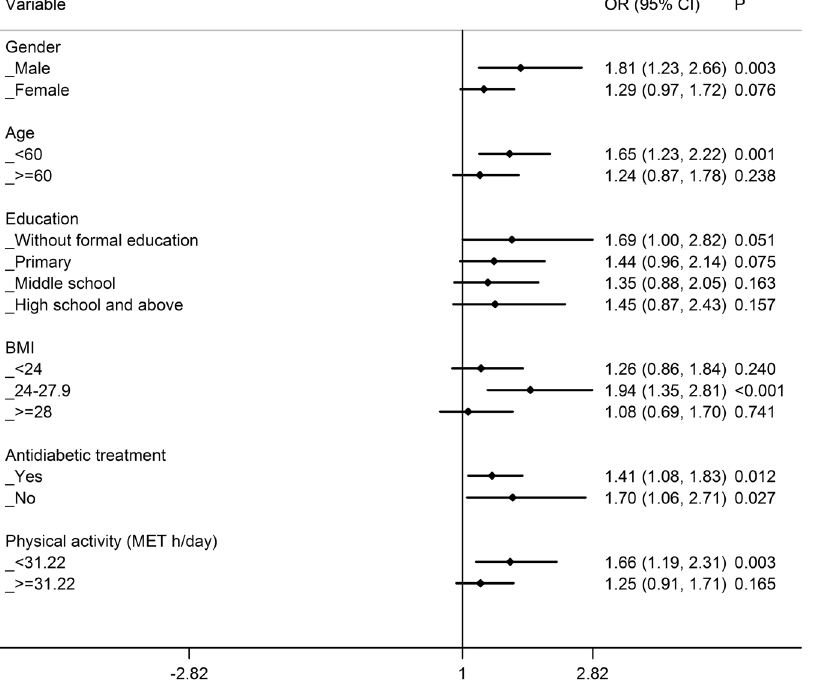
Figure 2. Stratified analysis of the comparison of poor glycaemic control between T2D patients with maternal history of diabetes and patients without a FH of diabetes by age, gender, education, BMI, antidiabetic treatment and physical activity. Logistic regression was used to estimate the OR (95%CI) and each stratified analysis was adjusted for age, gender, education, BMI, antidiabetic treatment, physical activity, smoking, drinking, spouse with diabetes and duration of diabetes except the corresponding stratification factor. OR: odds ratio; CI: confidence